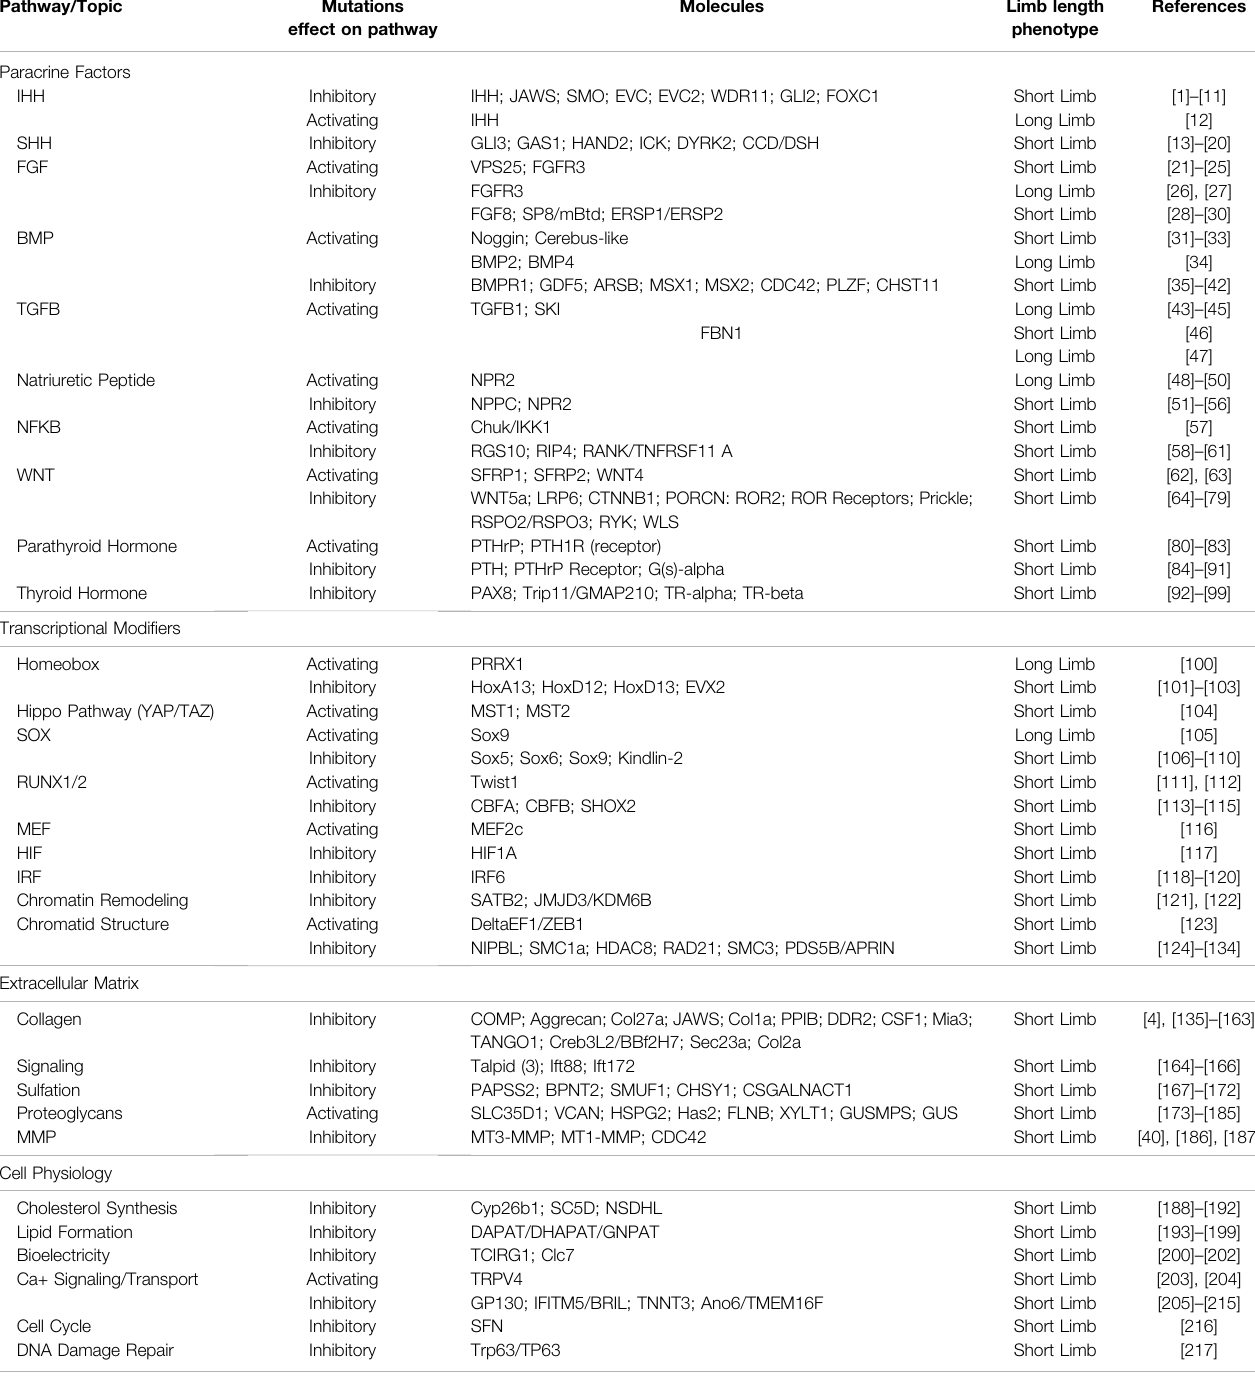
TABLE 1 | Limb length phenotypes in human, mouse, and